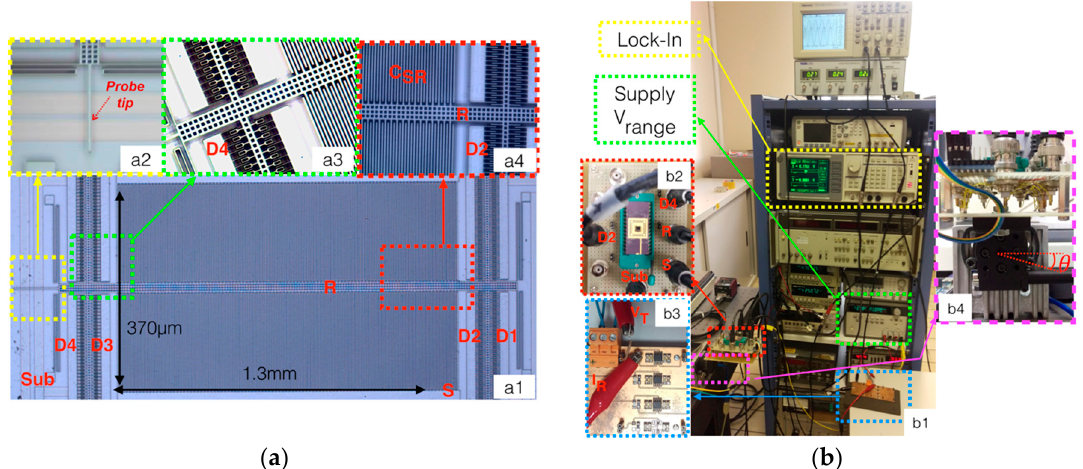
Figure 2. ( a1 ) Image of the fabricated MEMS device with ( a2 ) enlarged views of the probe tip; ( a3 ) driver D4; ( a4 ) driver D2 and capacitive position sensor (cid:1829) (cid:3020)(cid:3019) ; ( b1 ) Experimental setup with ( b2 ) enlarged views of the force sensor under test; ( b3 ) the transimpedence amplifier and ( b4 ) the rotating stage.